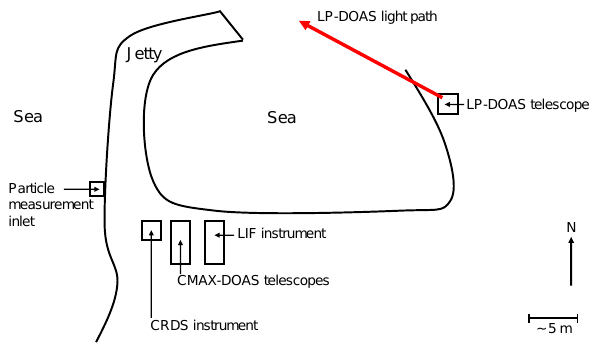
Fig. 2. A schematic of the Roscoff measurement site at high tide. Highlighted instrumentation includes LIF, LP-DOAS, Concurrent Multi Axis DOAS (CMAS-DOAS), Cavity Ringdown Spec- troscopy (CRDS) and particle number and size-distribution mea-